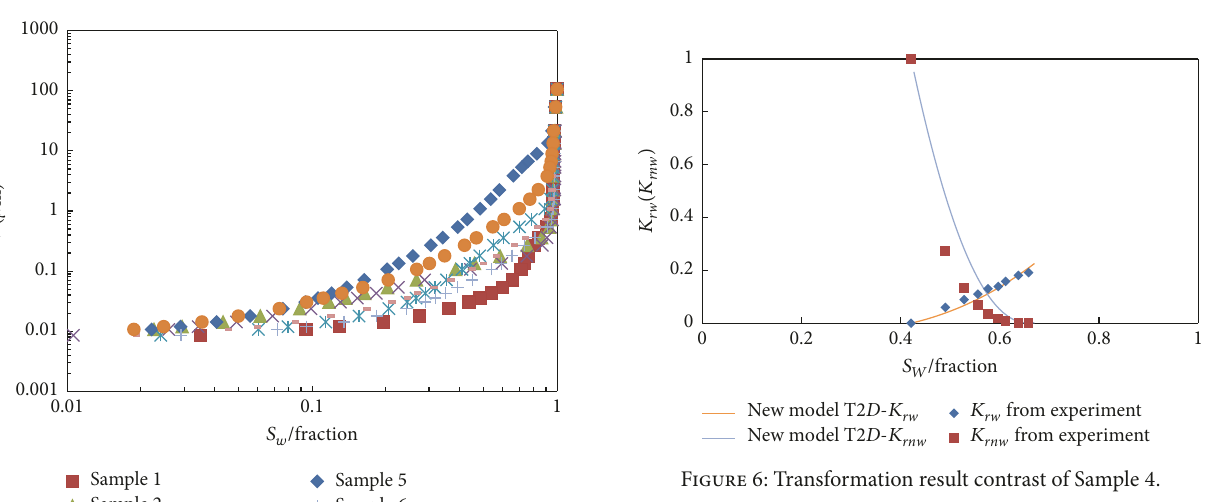
Figure 5: 𝐼 - 𝑃 𝐶 transformed by the piece-wise method.